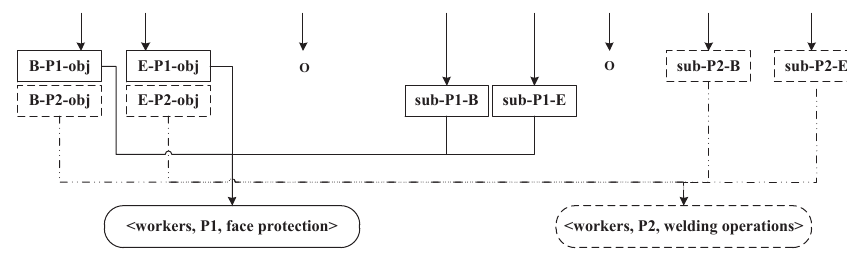
Figure 3. Gold annotation for an example sentence based on our tagger.